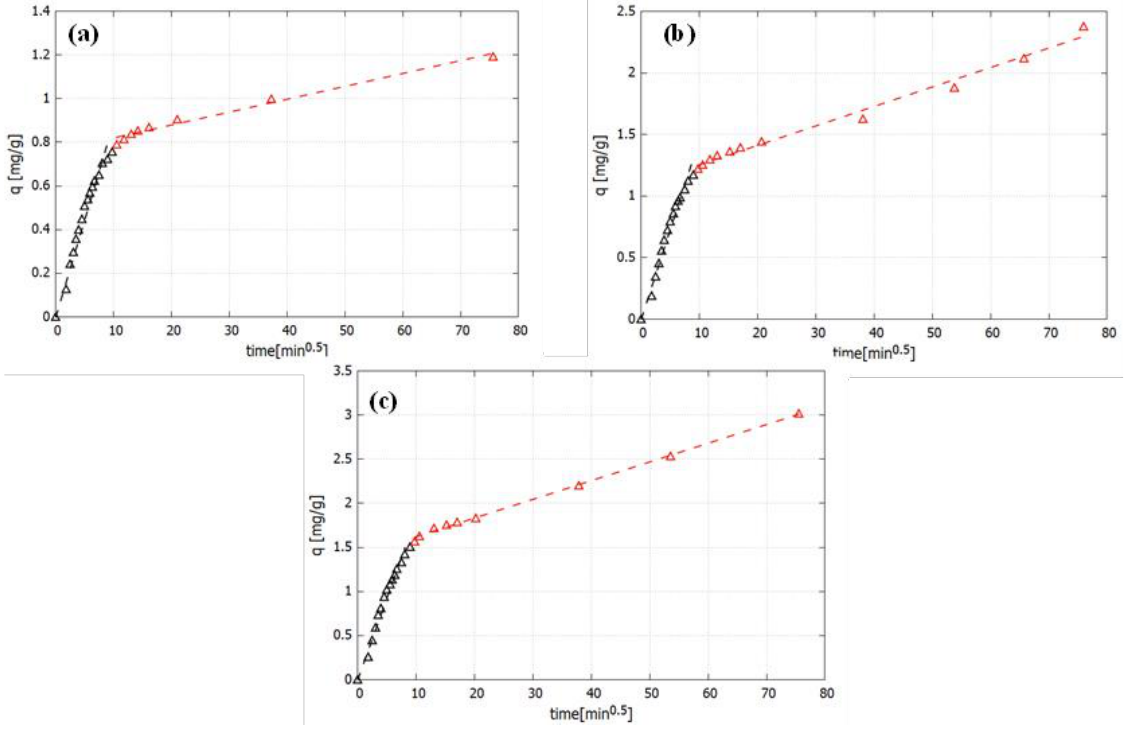
Figure 7. Intraparticle diffusion model of Cr(VI) adsorption on silica-based xerogel of ( a ) 36.53, ( b ) 55.41 and ( c ) 73.7 mg/L starting concentrations; black triangles: faster first absorption phase, red triangles: slower second absorption phase.